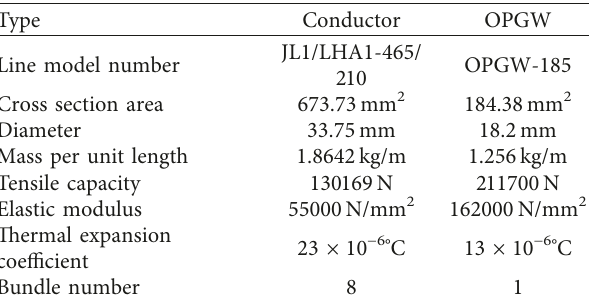
Table 2. Simulations were conducted using the finite element software SAP2000.